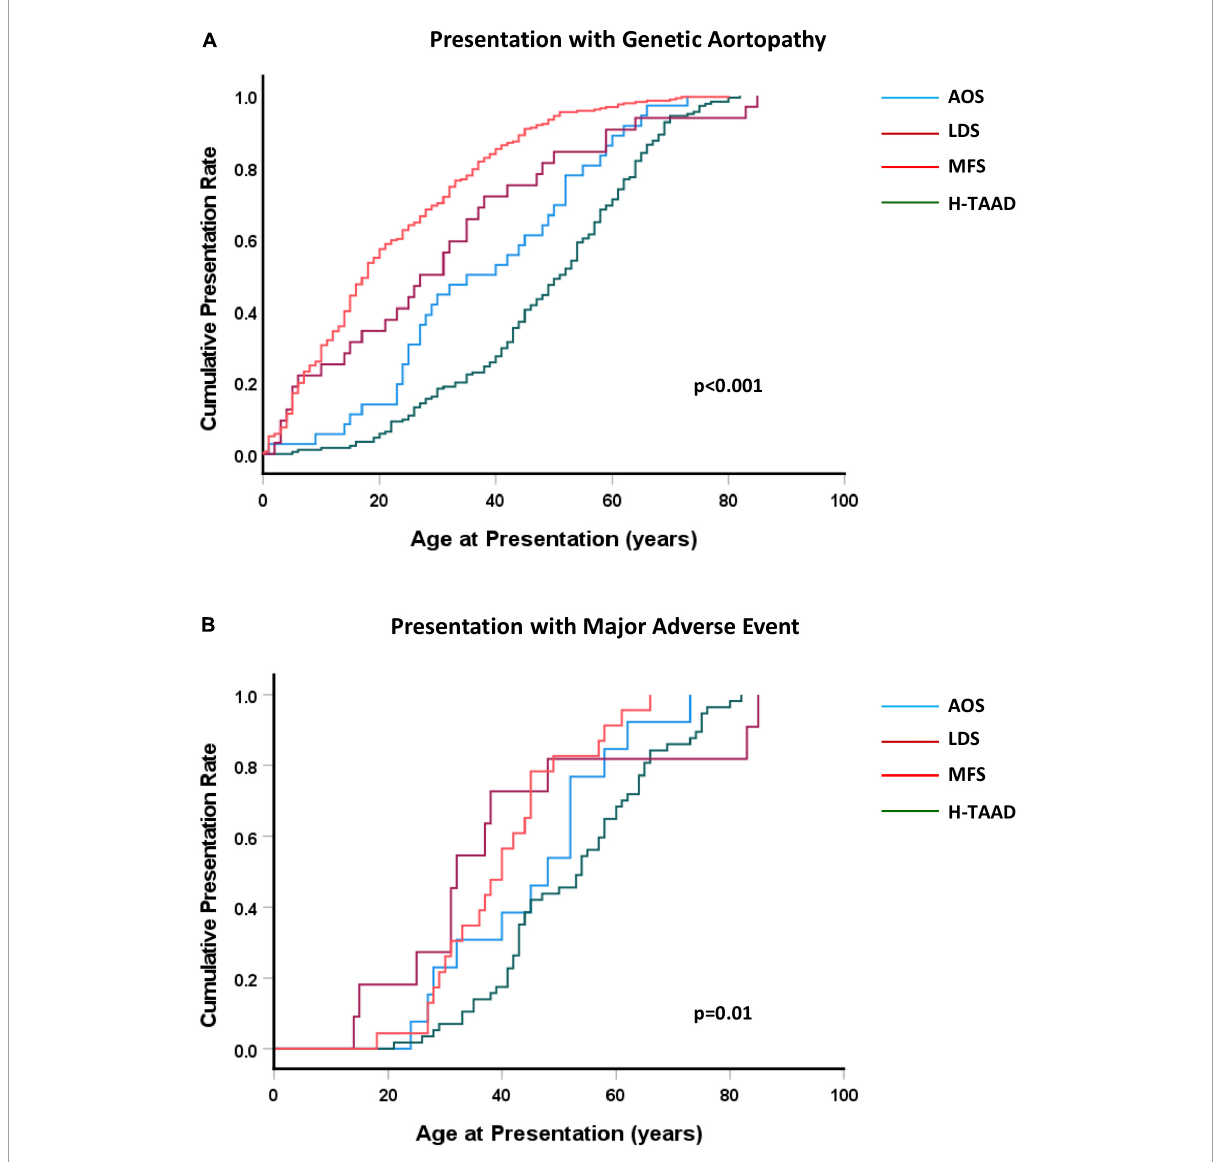
FIGURE1 (A) Cumulative presentation rate, according to age, for different heritable aortopathies. (B) Cumulative presentation rate with MACE, according to age, for different heritable aortopathies. Abbreviations as per text.